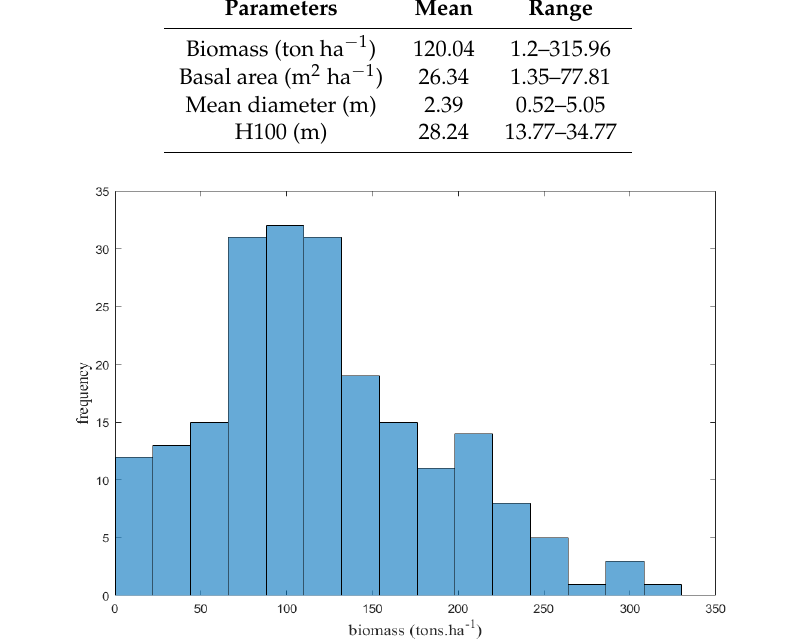
Table 1. Summary statistics of the biophysical parameters measured within plots with 10 m radius. Parameters